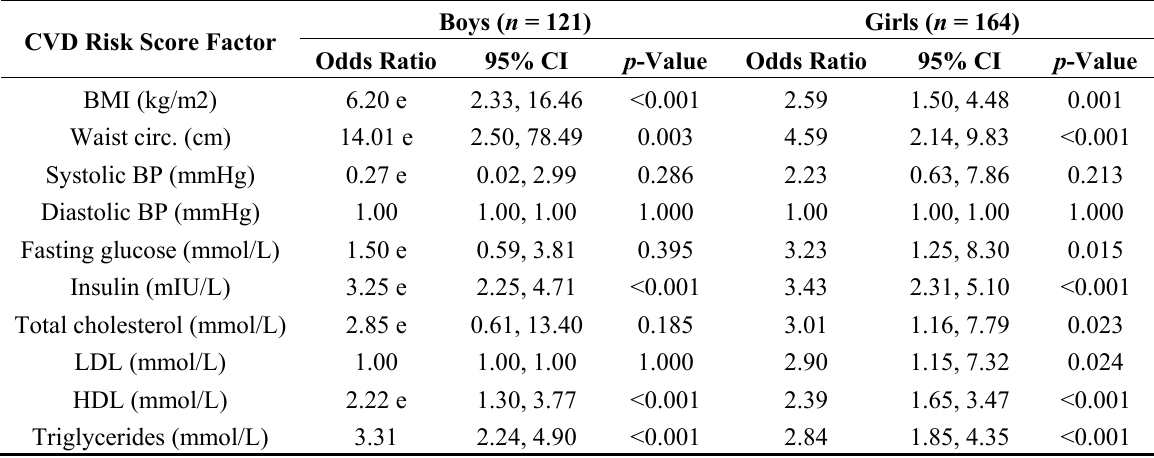
Table 5. Odds ratios, 95% confidence intervals (CI) and p -values from multivariate logistic regression models of CVD risk score on individual multifactor CVD risk score factors and total energy (e indicates total energy was significant in the model at the 5% level).